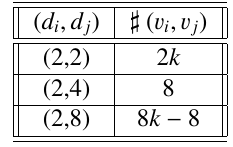
Table 1. The edge partition table of C 2